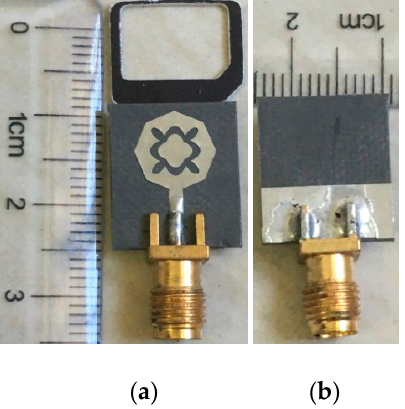
Figure 11. Fabricated prototype: ( a ) front view, ( b ) rear view.